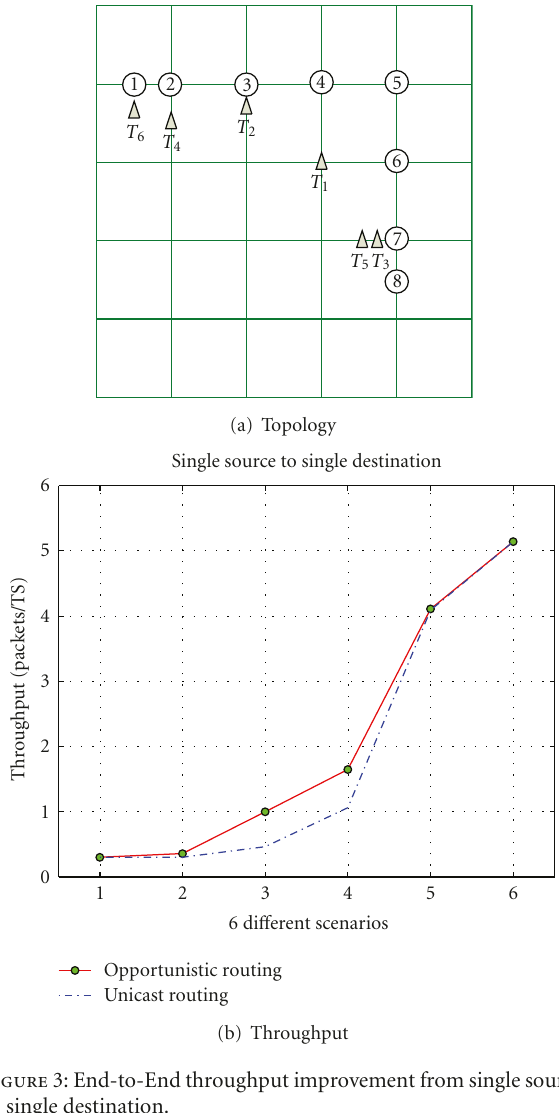
Figure 3: End-to-End throughput improvement from single source to single